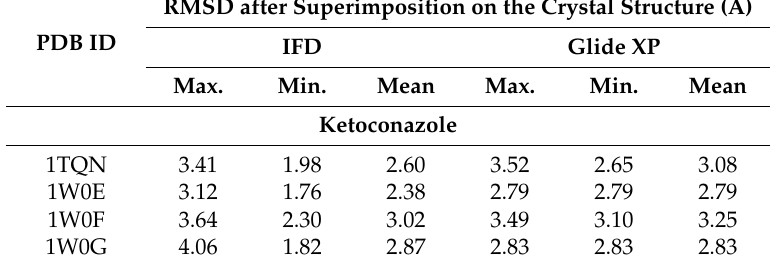
Table 3. Superimposition of ligands after docking the overall crystal structure of CYP3A4. RMSD after Superimposition on the Crystal Structure (Å) PDB ID IFD Glide XP Max. Min. Mean